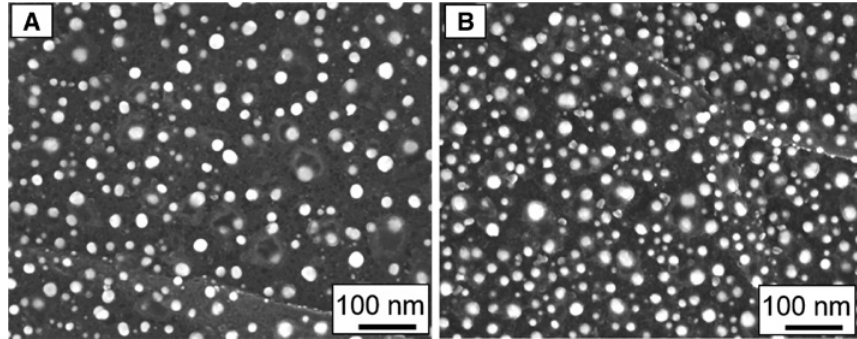
Figure 2: SEM images of the graphite films modified by ultrathin Ag layers with different thicknesses. (A) 1 nm and (B) 2